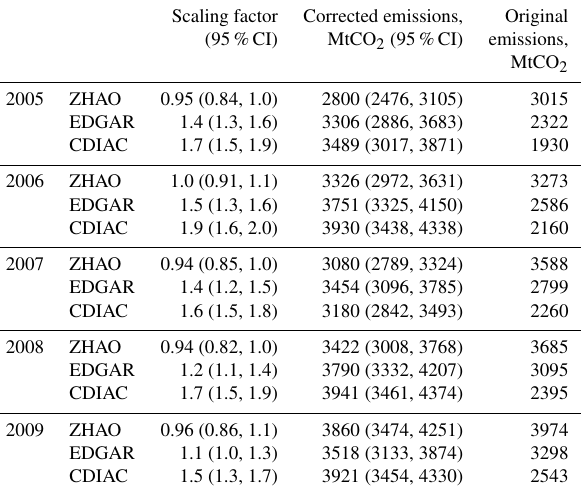
Table 2. Annual scaling factors (95% CI) and corresponding cor- rected emissions for the L_0.90 inventory evaluation